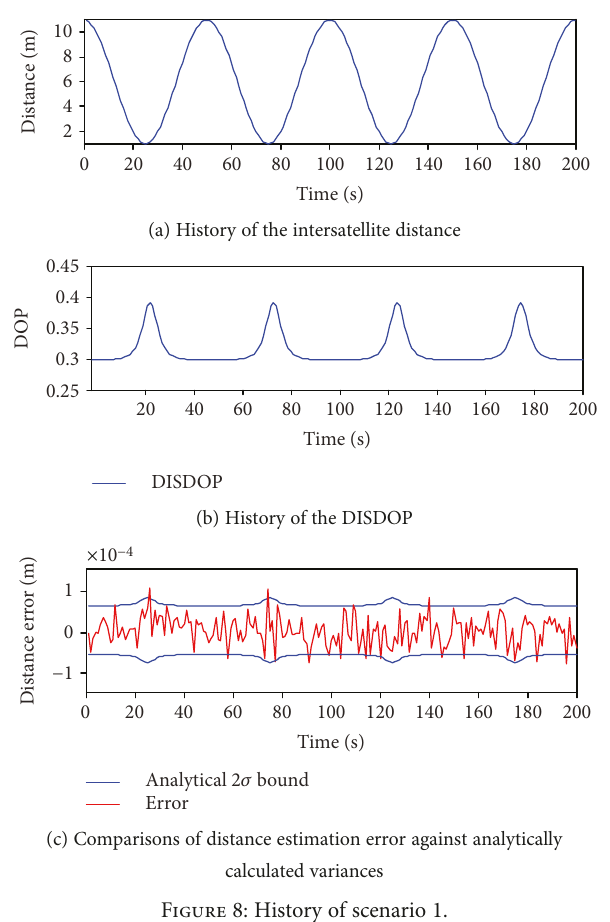
Figure 8: History of scenario